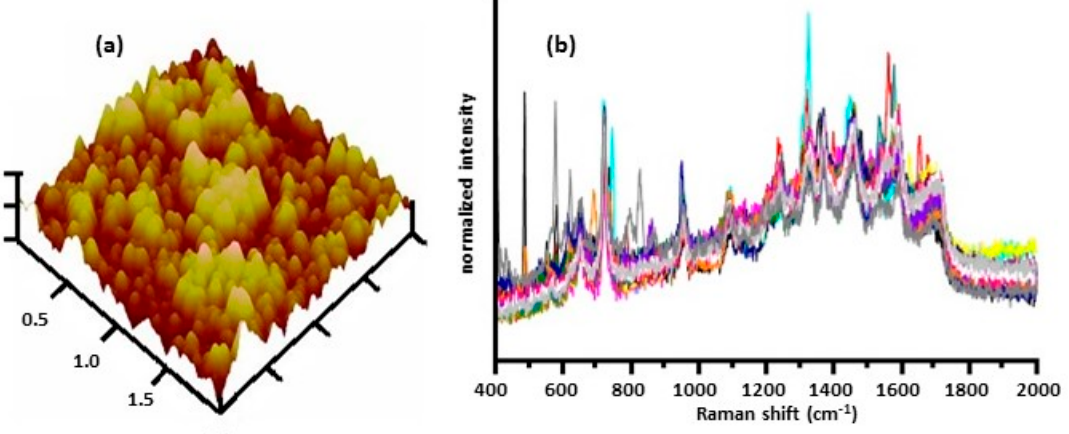
Figure 8. ( a ) AFM image of nanostructured PPX-Cl film deposited with 60 nm Au film [50]. ( b ) SERS spectra collected for 25 random cells on 1 mm 2 area showing a highly reproducible fingerprint for E. coli [50]. Spectra were obtained using 785 nm excitation. Reproduced with permission from John Wiley and Sons.